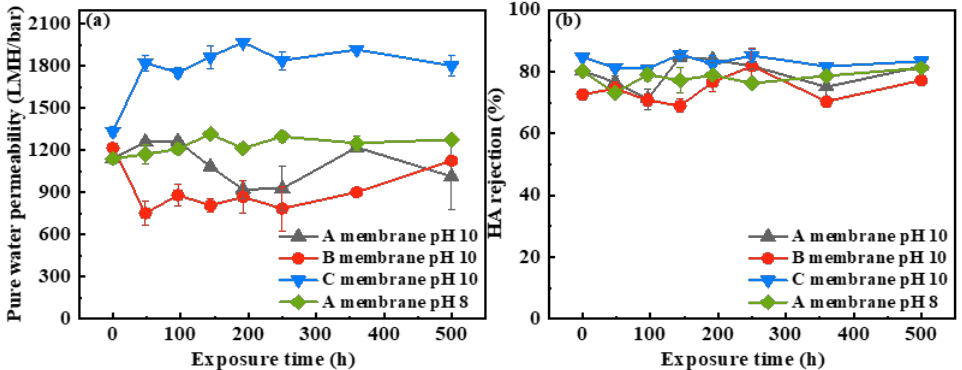
Figure 5. ( a ) Pure water permeability and ( b ) HA rejection of A, B, and C membranes as a function of NaOCl exposure time.